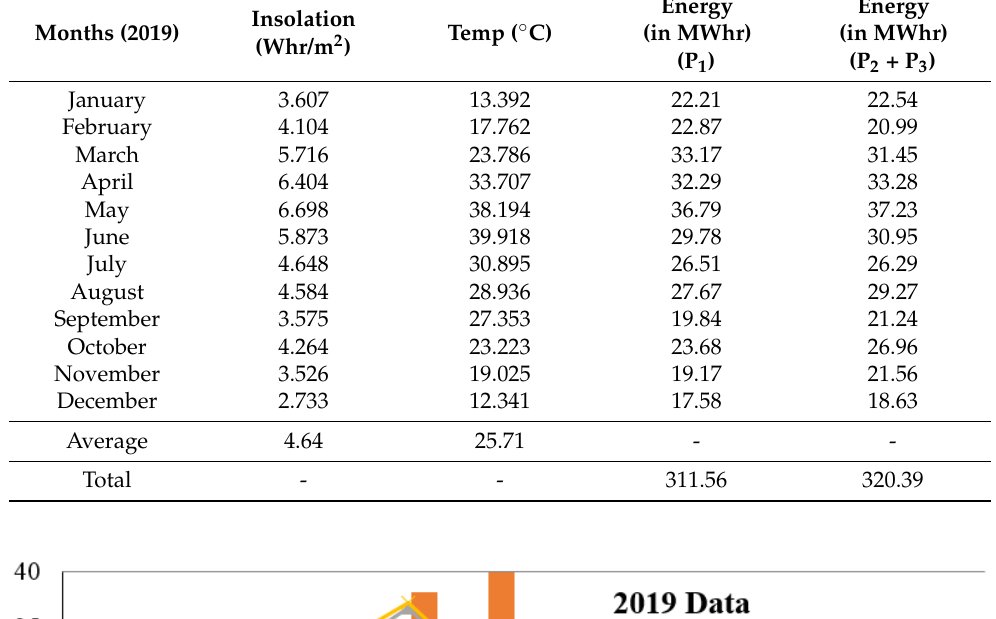
Table 6 . Comparison of Generated Energy in 2019 (P 1 vs. P 2 + P 3 ) . Table 6. Comparison of Generated Energy in 2019 (P 1 vs. P 2 + P 3 ).